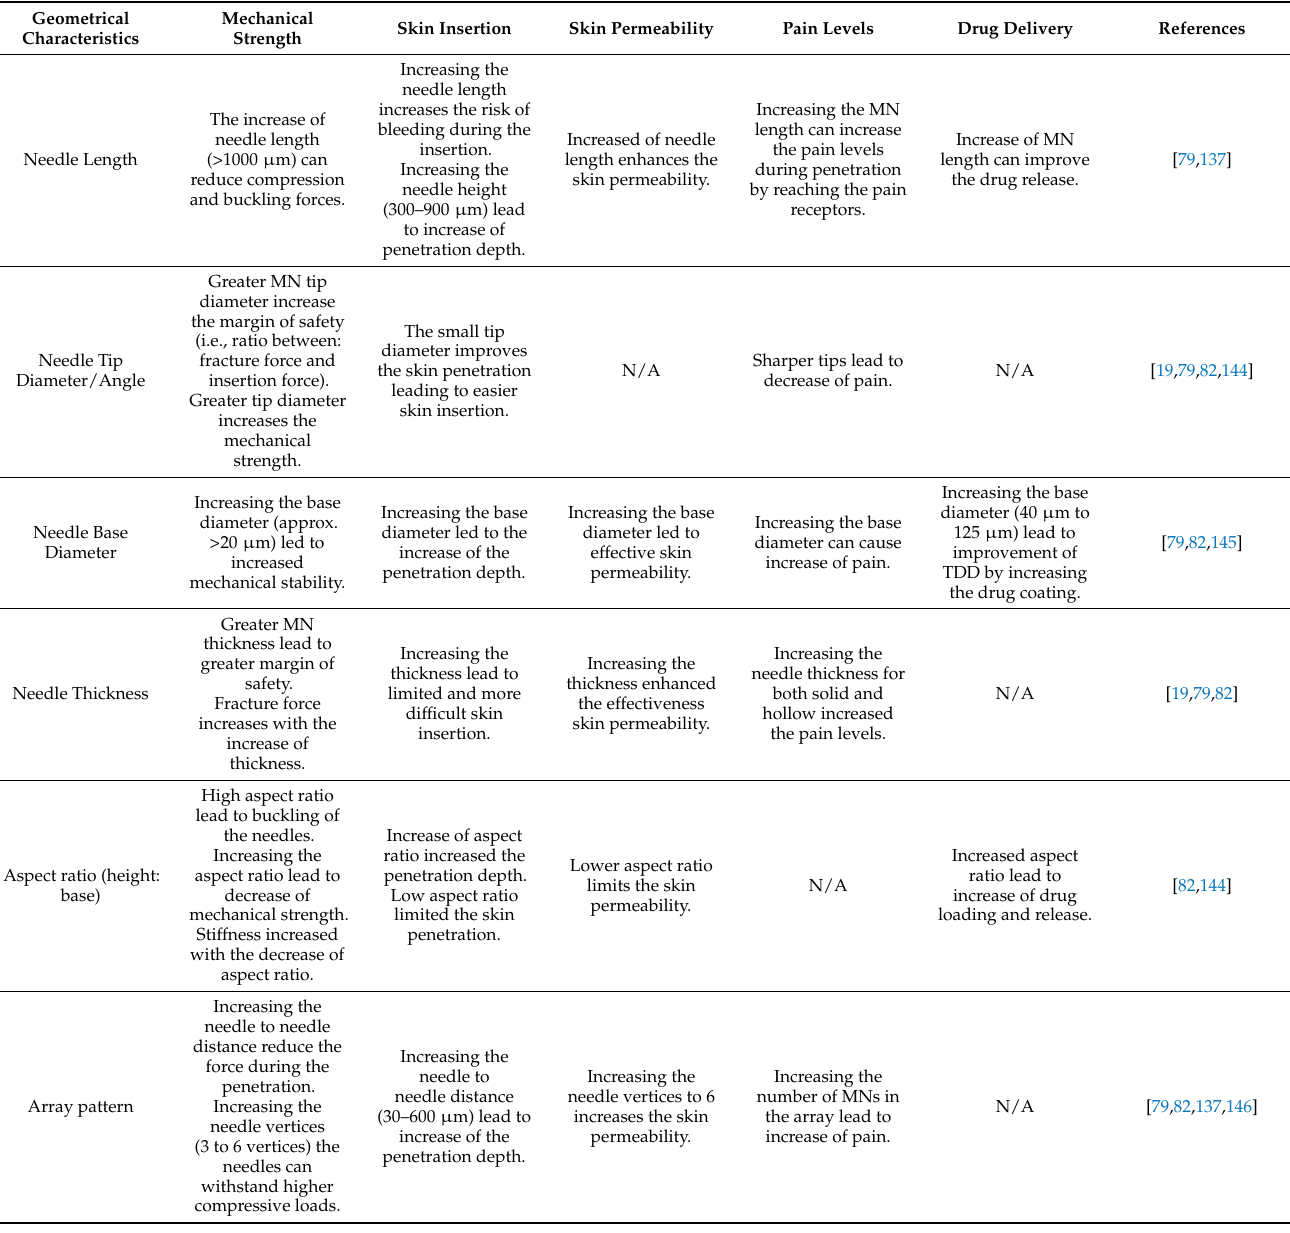
Table 4. Overview of the geometrical characteristic affect the MN arrays